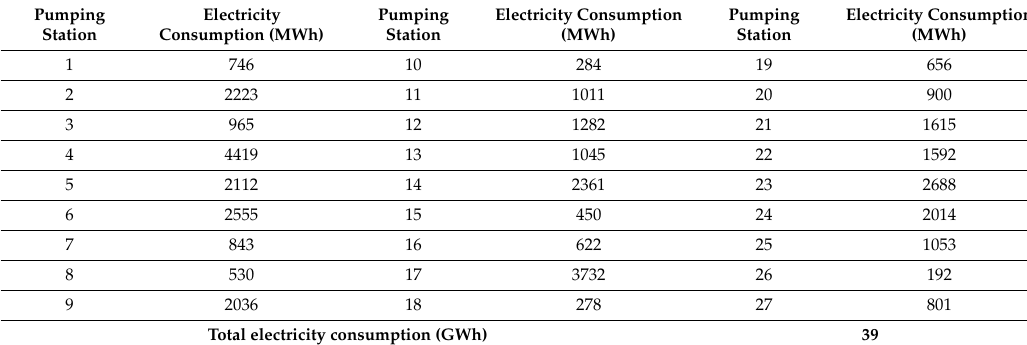
Table A1. Power consumed annually from each pumping station.